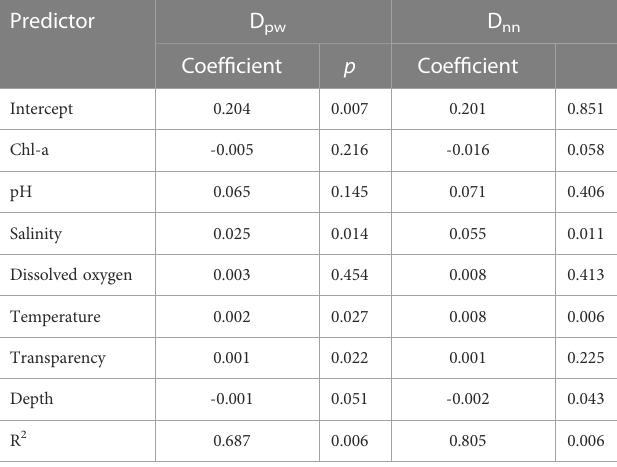
TABLE 2 Results of multiple regression on distance matrices (MRM) analyses for the effect of environmental variables in phylogenetic beta diversity both at deep (D pw ) and shallow (D nn ) phylogenetic levels from spring and autumn nektonic communities in the waters of Weizhou